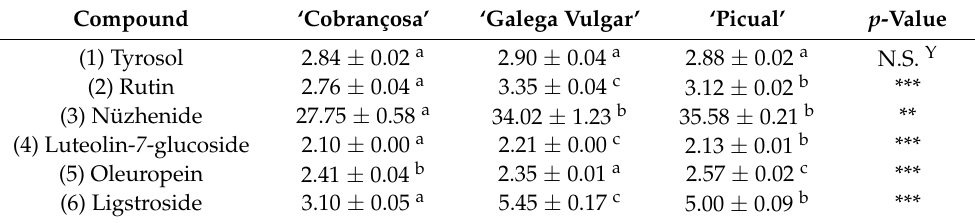
Table 3. Content of individual phenolics (mg g − 1 DW) of olive seeds from different cultivars. Compound ‘Cobrançosa’ ‘Galega Vulgar’